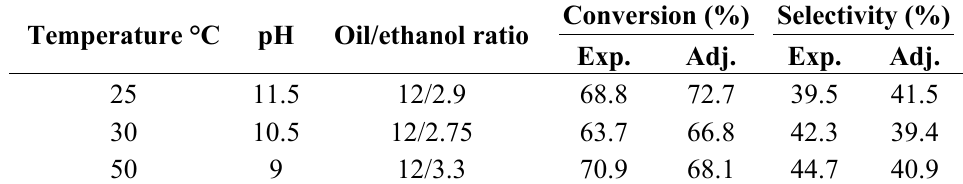
Table 6. Validation experiments of proposed models for the enzyme BIOLIPASE-R. (Experimental versus Adjusted